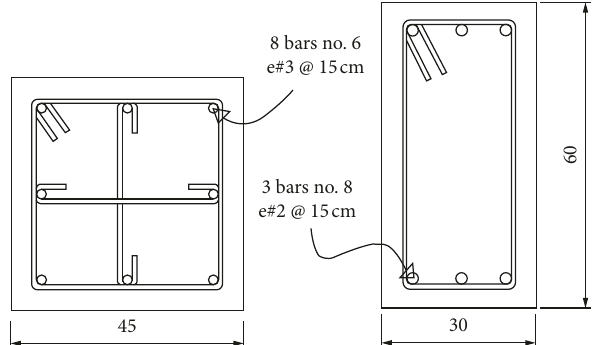
Figure 19: Optimal beam and column sections for levels 7–9 of individual 1, model RC-9.